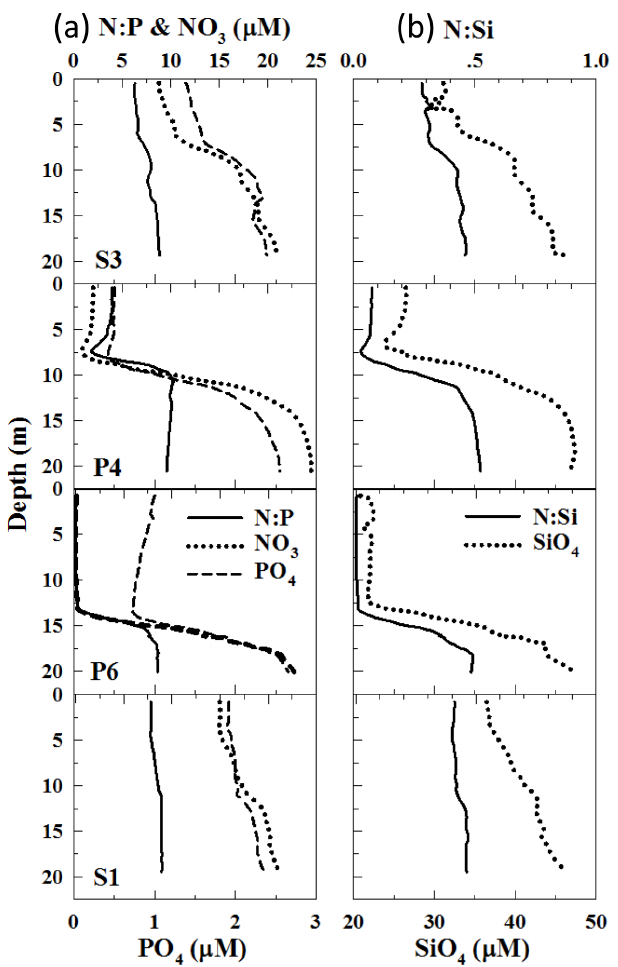
Figure 5. Selected vertical profiles at S1 during the time series (T1, T3, T8 and T11) on 8–9 August 1991. (a) NO 3 , PO 4 and N:P ratios. (b) SiO − and N:Si , PO 3 − and N:P ratios. (b) SiO − 4 3 4 4